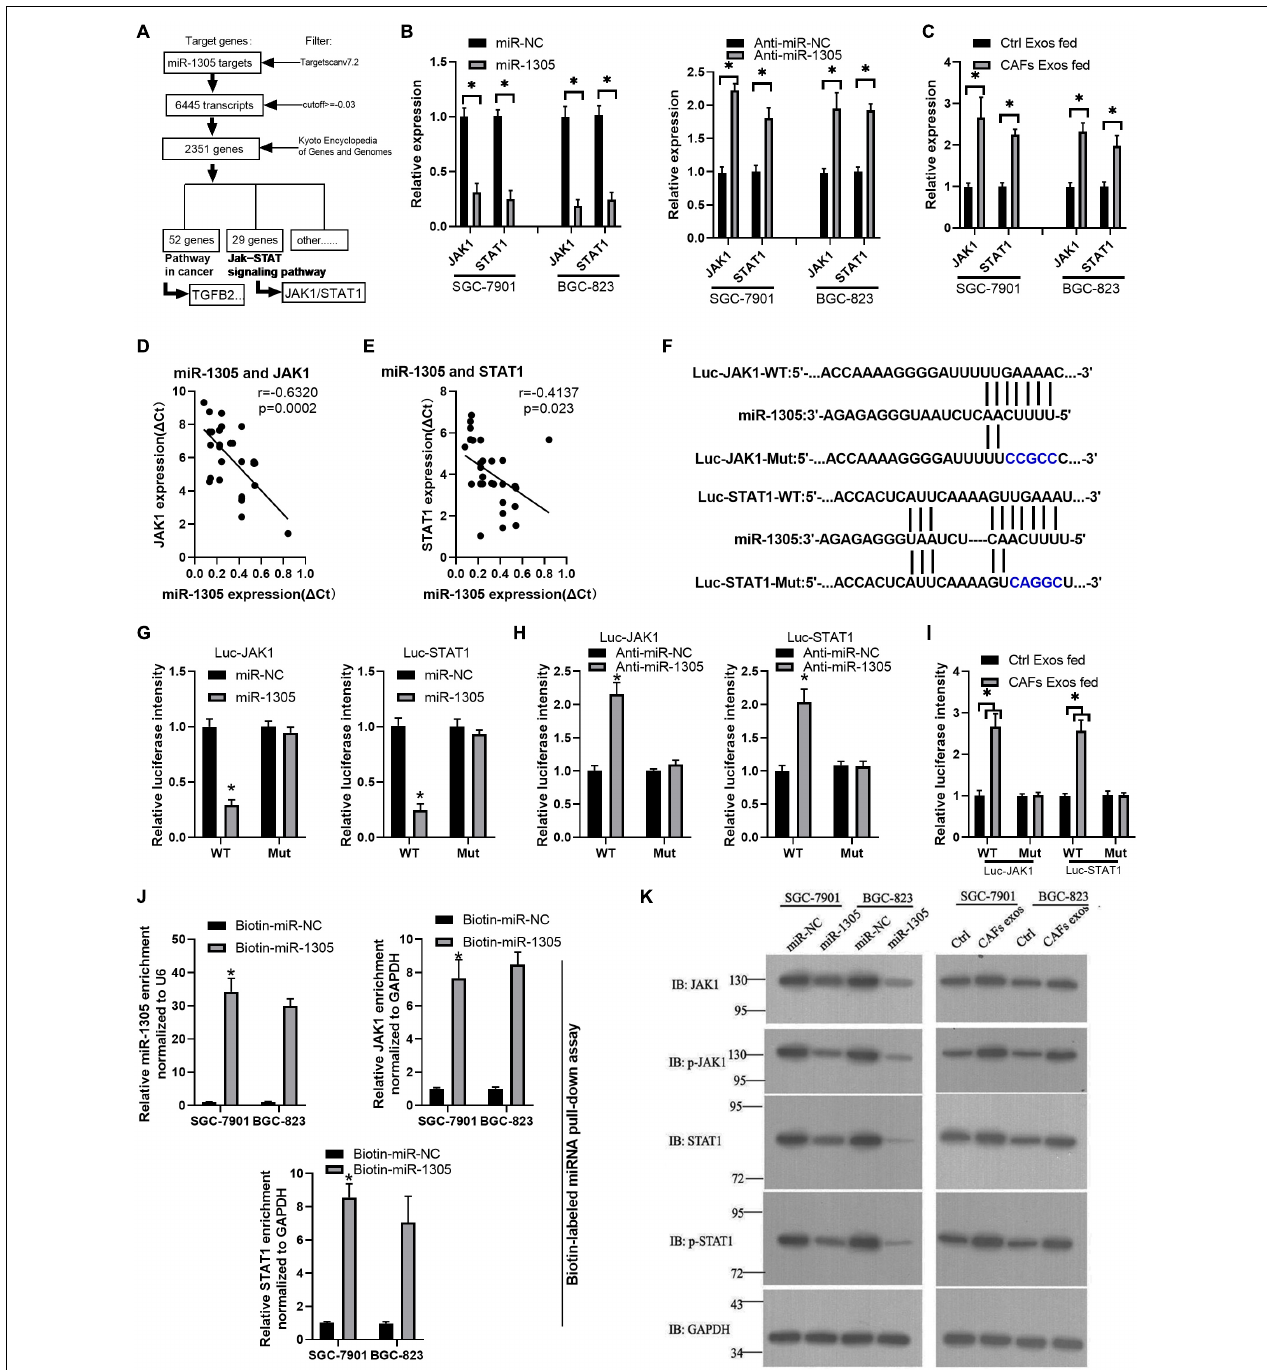
FIGURE 7 | miR-1305 inhibits migration, invasion and proliferation in GC cells via JAK1 and STAT1 downregulation. (A) Analysis of genes and pathways downstream of miR-1305. (B) The expression of JAK1 and STAT1 in SGC-7901 and BGC-823 cells transfected by miR-1305 mimic or anti-miR-1305 by qRT-PCR; (C) The expression of JAK1 and STAT1 in SGC-7901 and BGC-823 cells treated with exosomes derived from normal cells and CAFs, as assessed by qRT-PCR. (D) Correlation analysis between JAK1 and miR-1305 in GC tissues ( n = 30). (E) Correlation analysis between STAT1 and miR-1305 in GC tissues ( n = 30). (F) Putative binding sites between miR-1305 and wild-type (WT) or mutated JAK1 (or STAT1) sequences. (G) Luciferase activity of JAK1 and STAT1 reporters in GC cells which transfected by miR-1305 or controls. (H) Luciferase activity of JAK1 and STAT1 reporters in GC cells that were transfected with anti-miR-1305 or controls. (I) Luciferase activity of JAK1 and STAT1 reporters in GC cells that were treated by exosomes derived from normal cells or CAFs. (J) RNA RIP experiments were performed with GC cells that were transfected with biotin-miR-1305 mimics or controls, and qRT-PCR analysis the enrichment of miR-1305, JAK1, and STAT1 in GC cells. (K) The protein level of JAK1 and STAT1 in SGC-7901 and BGC-823 cells transfected with miR-1305 mimics or control mimics, and CAF-derived exosomes or control exosomes ( ∗ P < 0.05).